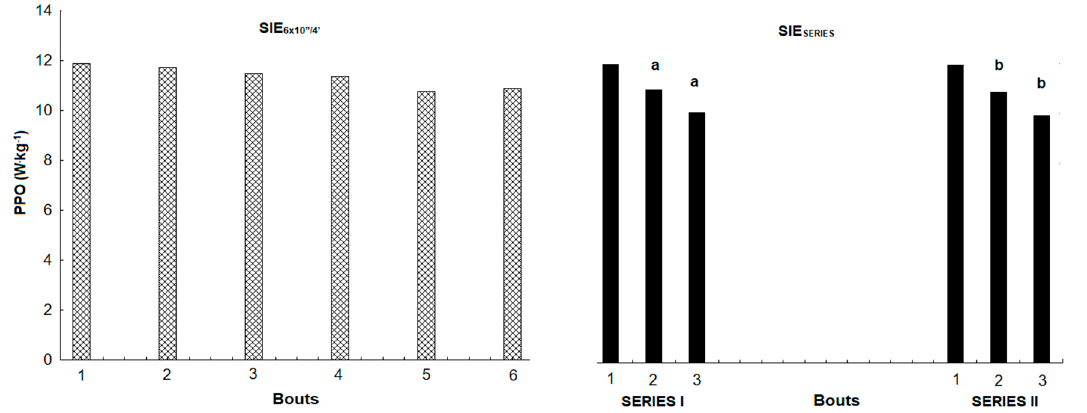
Figure 2. Changes in peak power output for each bout between both sprint interval exercise protocols. a —statistically significant di ff erence between PPO related to first bout in SERIES I ( p < 0.05), b —statistically significant di ff erence between PPO related to first bout in SERIES II ( p < 0.05). Table 2. Comparison of mechanical responses between both SIE protocols.